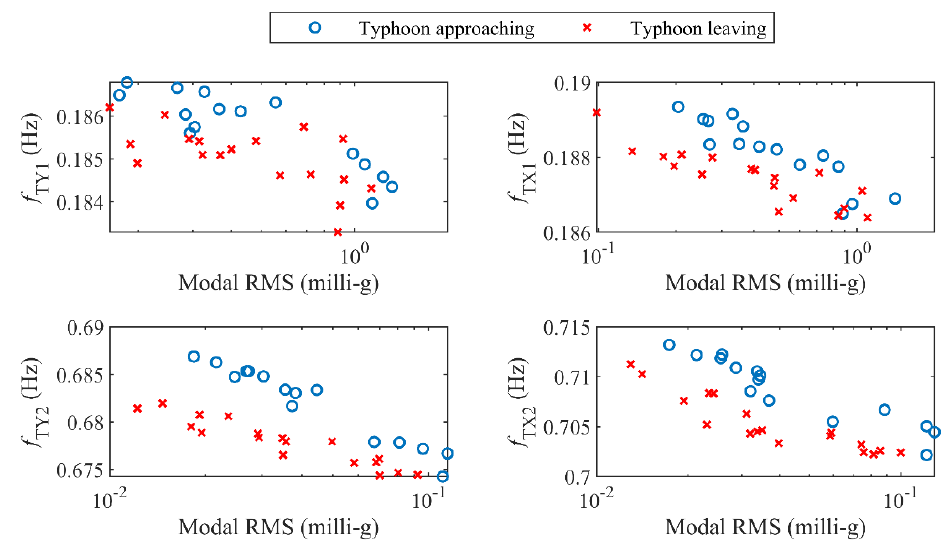
Figure 14. Relationship between modal frequency and modal RMS.